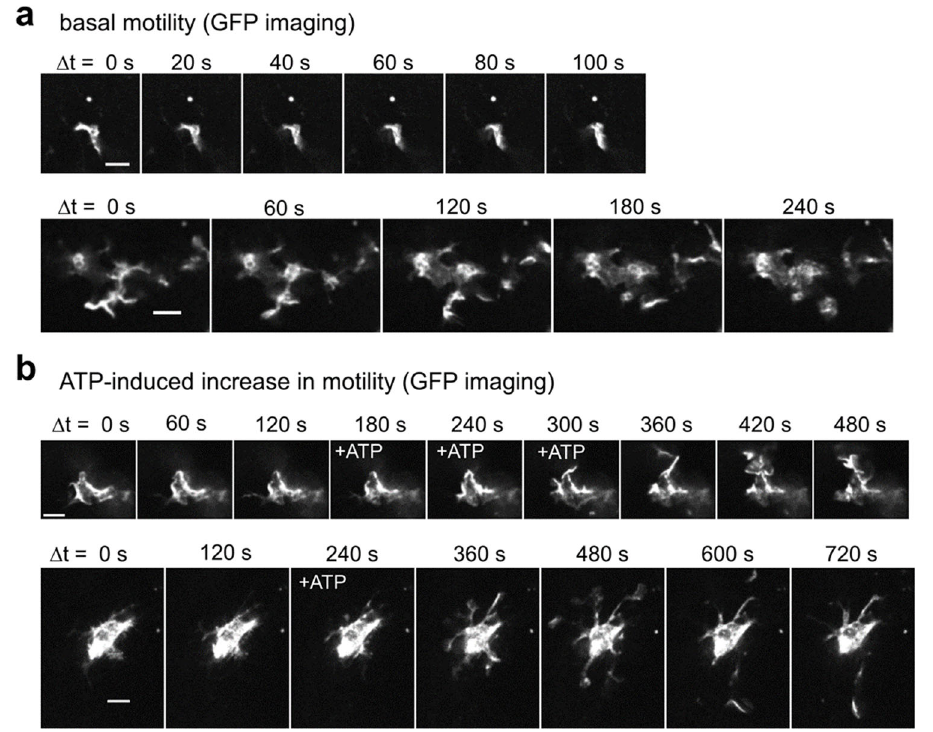
Fig. 6 Motility analysis of cerebellar microglia overexpressing GFP with our microglia-selective gene expression method. a , b Time-lapse GFP fl uorescent images (time indicated above the images) showing basal movements of microglial processes in a and ATP-induced motility upregulation of microglia in b (frames, when 100 µ M ATP was bath-applied, are indicated as ‘ + ATP ’ ; 3 min ATP application in the upper panel and 1 min in the lower panel of b ). The Upper and lower panels in a and b correspond to examples from different cells. Scale bars: 10 µ